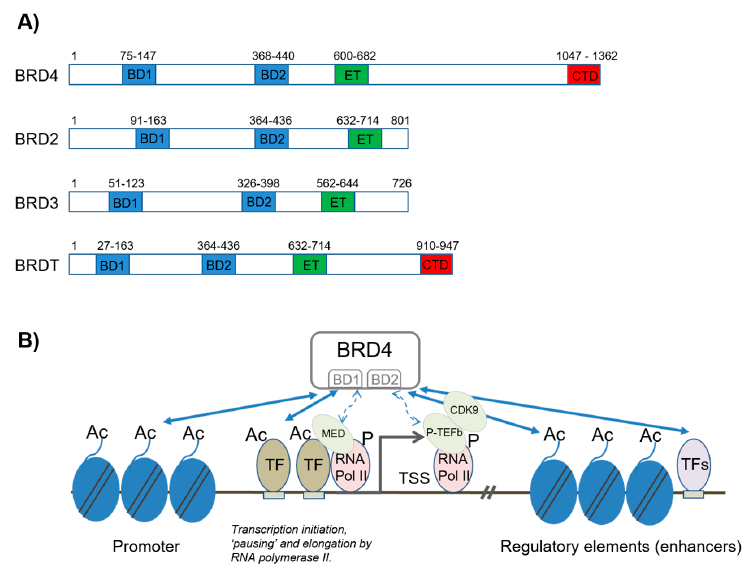
Figure 1. Schematic of domain organization of BET (bromodomain and extra-terminal domain) family proteins and the function of BRD4 in the regulation of promoter and enhancer activity. ( A ) Domain organization of human BET family members BRD4, BRD2, BRD3, and BRDT, as indicated. BET proteins contain two bromodomains (BD1 and BD2, respectively) and an extra-terminal domain (ET). BRD4 (long form) contains a carboxyterminal domain (CTD) that is not present in the other BET family members; ( B ) Schematic representation of the functions of BET family member BRD4 in the regulation of promoter and enhancer function (includes “super-enhancers”; see text for details). Through its BD1 and BD2 domains, BRD4 binds to acetylated lysines (Ac) in histones or transcription factors (TF). The binding of acetylated histones by BRD4, at transcription start sites (TSS), mediates transcriptional co-activation and elongation via RNA polymerase II (RNA pol II) and Mediator (Med) and pTEFb signaling complexes, respectively (see text for details). BRD4 can also bind acetylated lysines in histones or TF in enhancer elements, thereby contributing to long-range control of gene activity (see text for details). TF binding sites are depicted as horizontal rectangles.